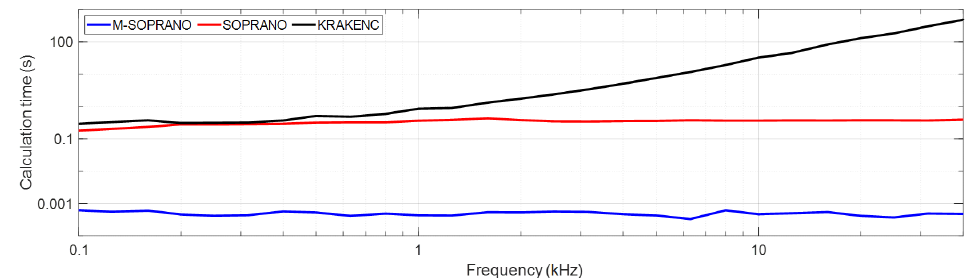
Figure 9. Comparisons for the calculation time of KRAKENC, SOPRANO and M-SOPRANO for an arbitrary